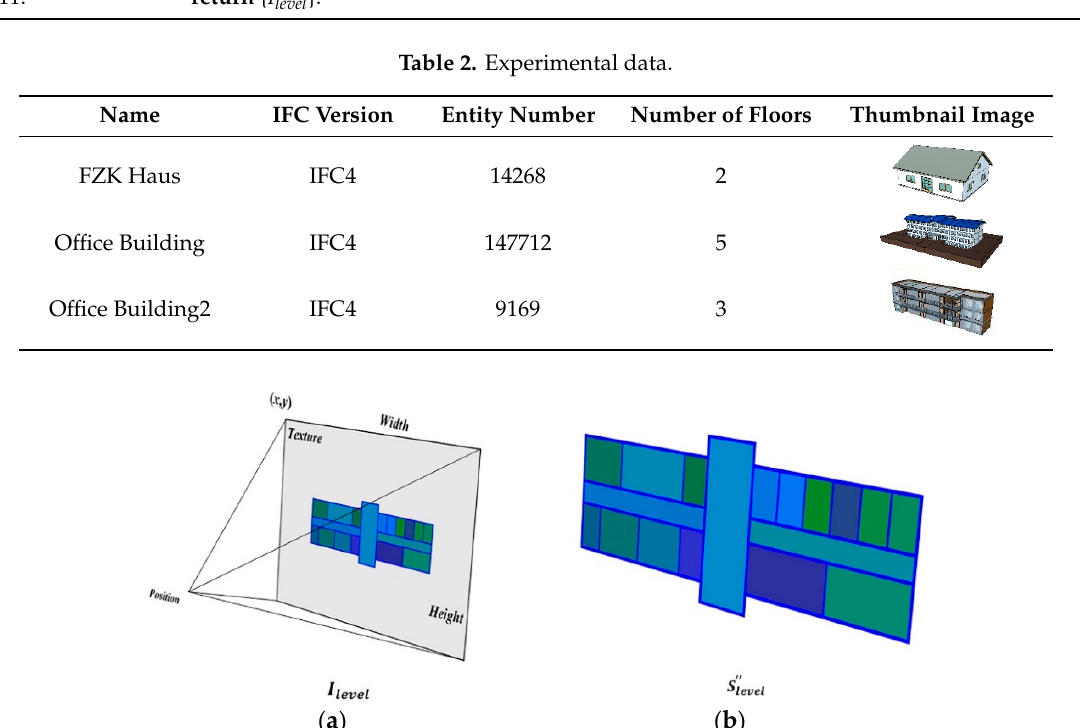
Figure 10. Diagram of the mapping and rasterization (sample data from Table 2. Office Building). ( a )